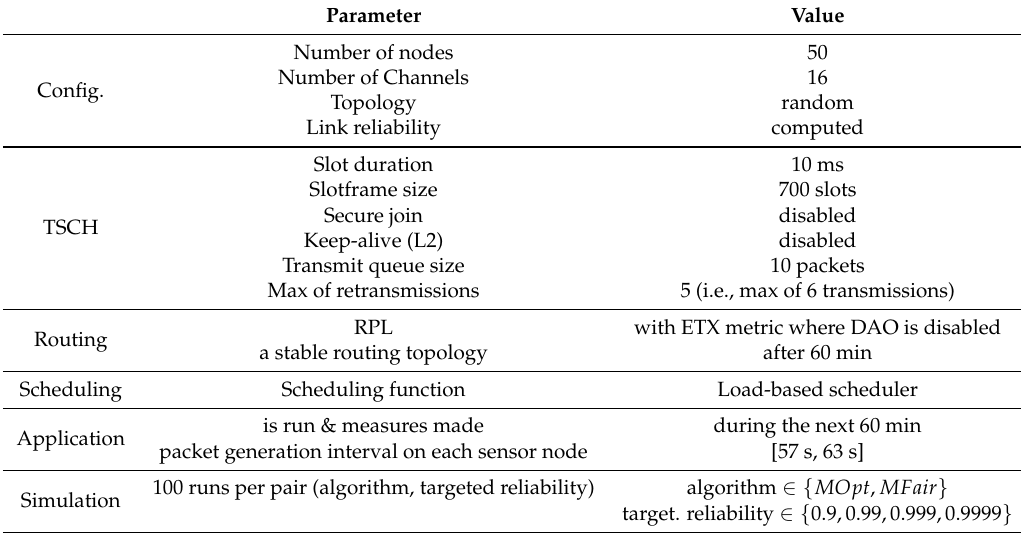
Table 9. Simulation parameters.